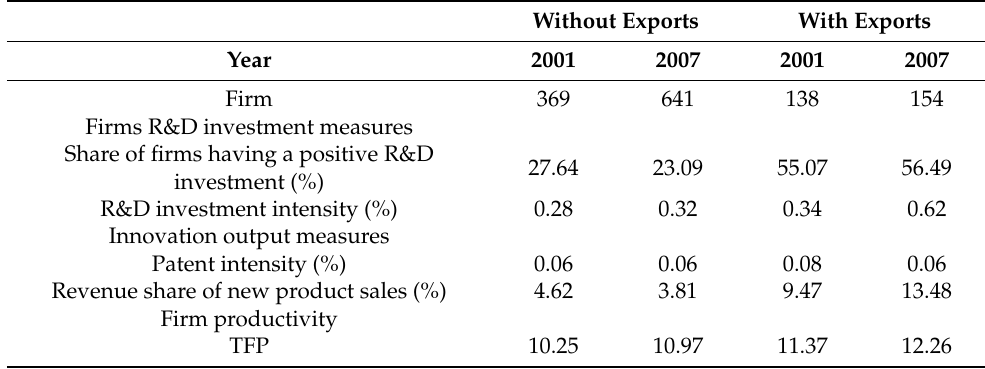
Table 6. Summary statistics of key variables among firms with or without